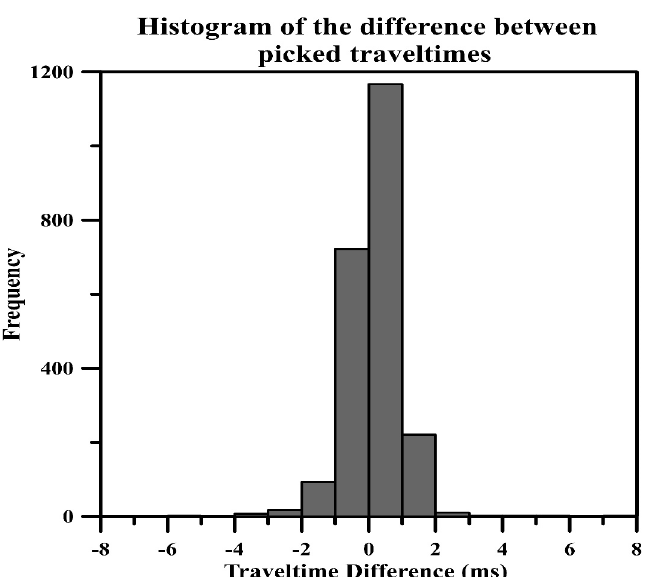
Figure 6. The histogram of the difference between first arrival traveltime picks of both conventional and land-streamer data sets. The differences between the traveltime picks of both data sets are smaller than ±4 ms.